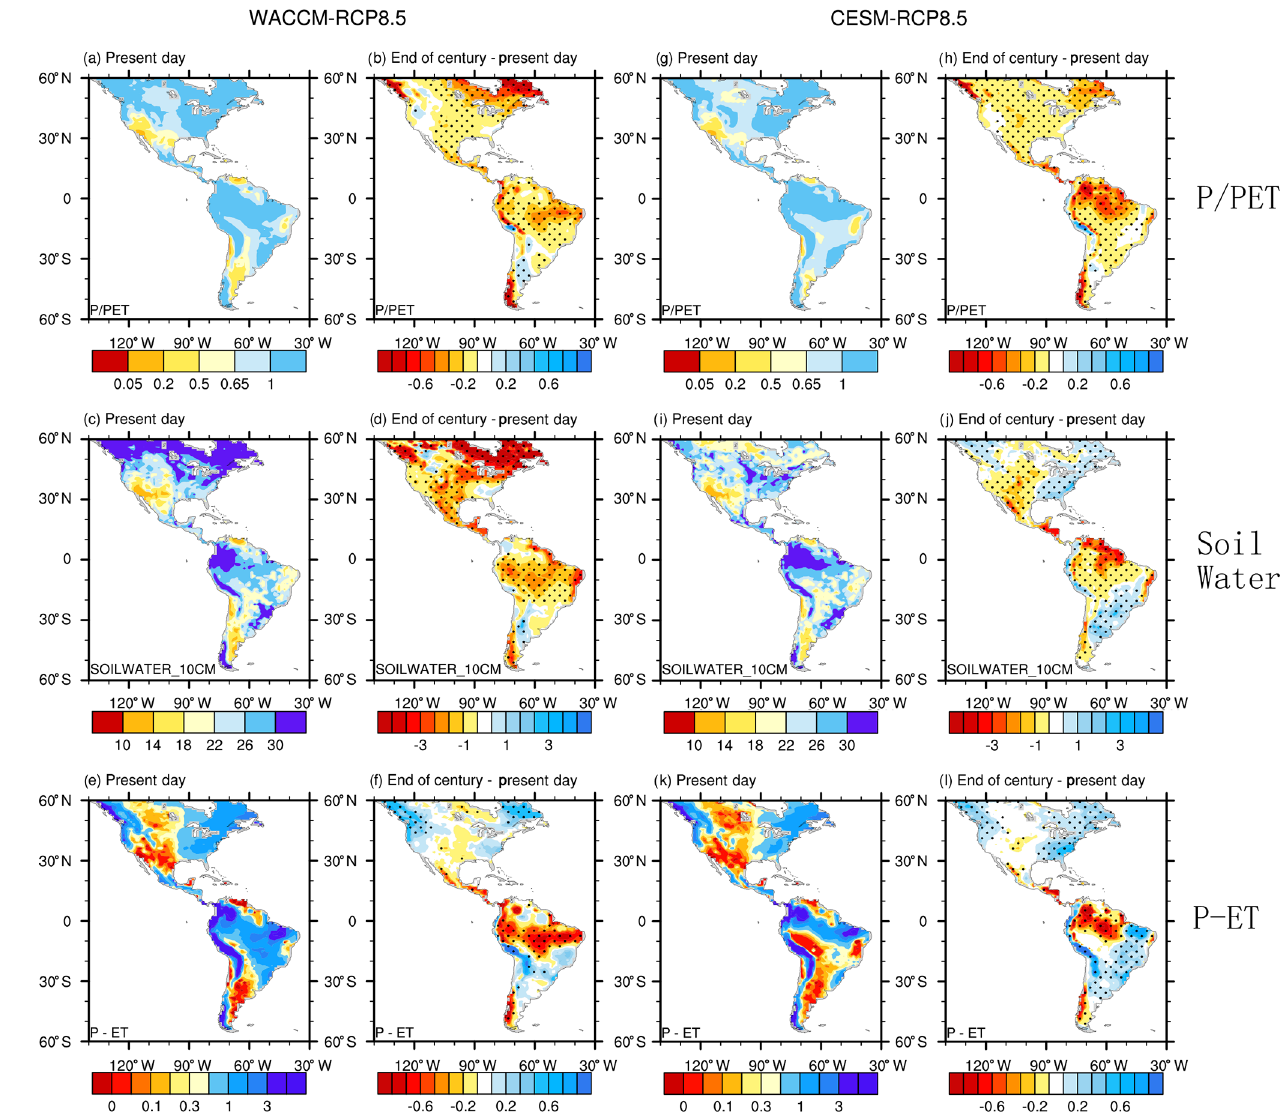
Figure 2. In the two left columns are WACCM-simulated P / PET (unitless), soil water (mm), and P-ET (mmd − 1 ) in the present day and at the end-of-century change under RCP8.5. The two right columns are the same as the left but for CESM. Note that all data here in Fig. 2 are without bias correction as in Fig. 1. The focused periods are the present day (2010–2019) and the end of the century (2086–2095). The areas with stippling in the panels labeled “End of century – present day” indicate where the differences are significant at a 95% confidence level following a Student’s T test. Similar results are presented in Fig. 5 but after bias correction and in relative terms